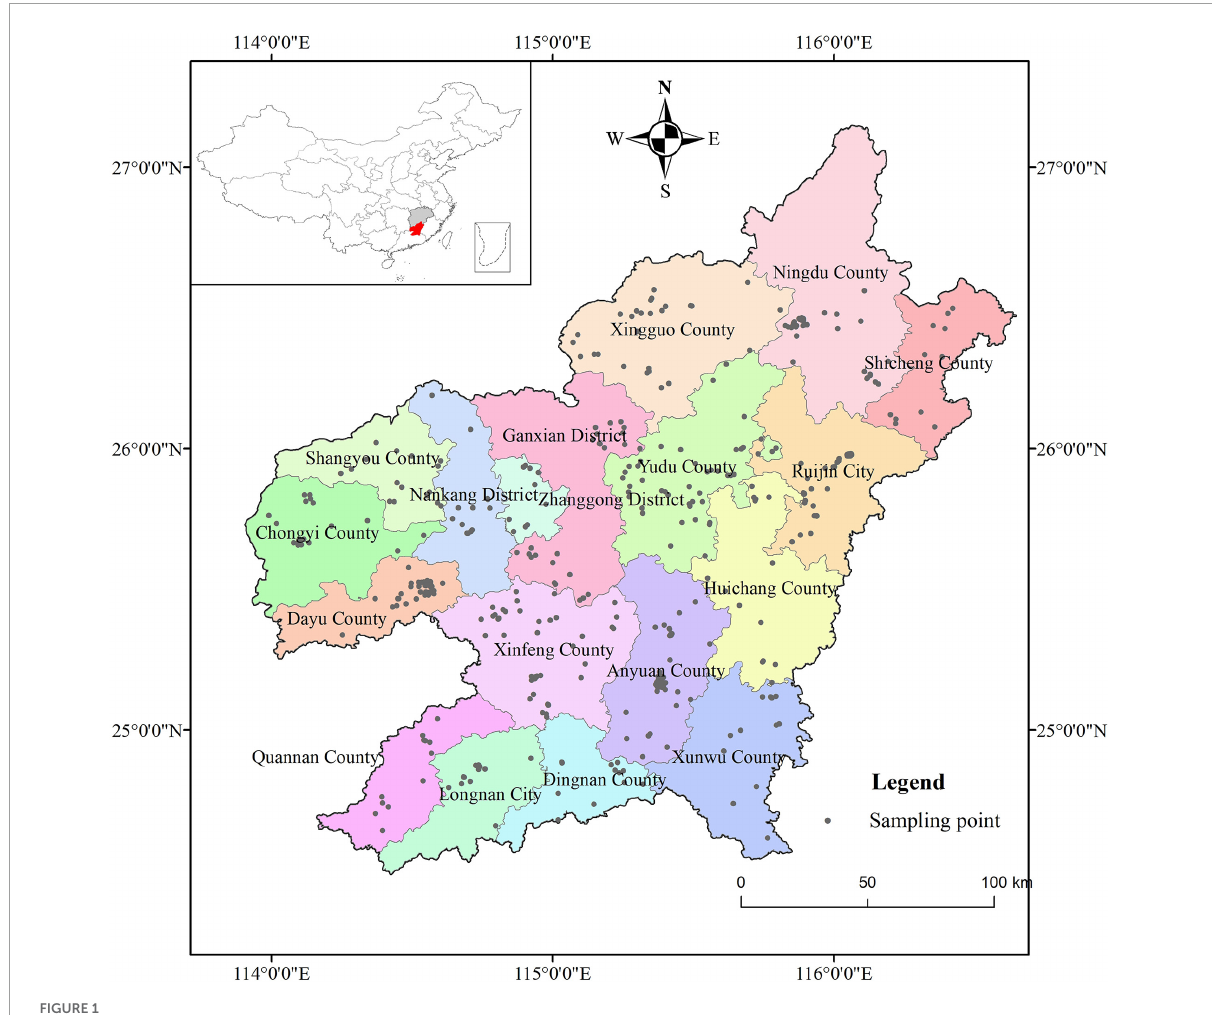
FIGURE1 Locations of the study area and 492 fruit sampling points in southern Jiangxi Province,